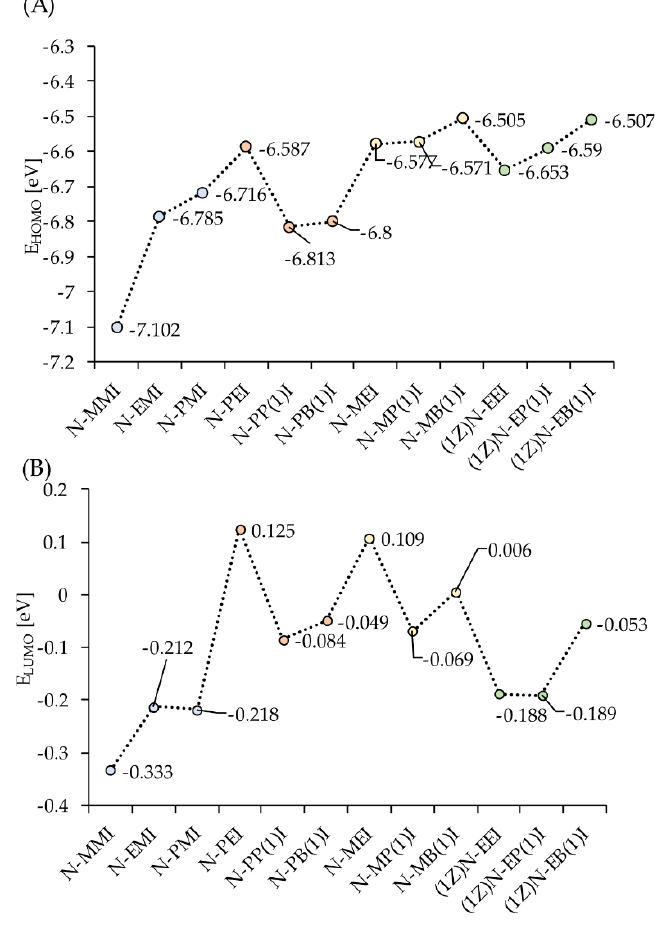
Figure 2. E HOMO ( A ) and E LUMO ( B ) of the investigated Schiff bases determined in the gas phase.